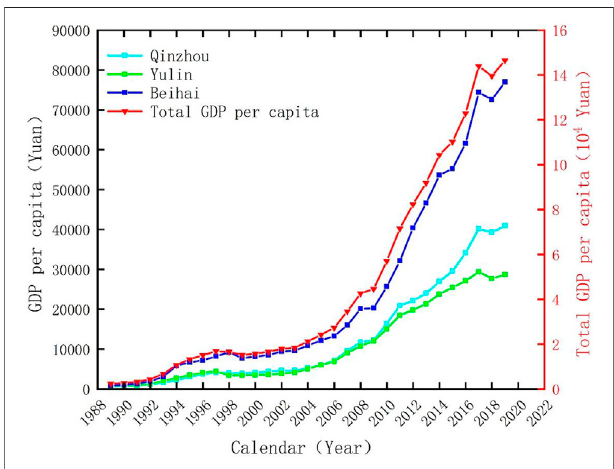
FIGURE 13 | Changes in the per capita GDP in the Nanliu River Basin from 1989 – 2019.